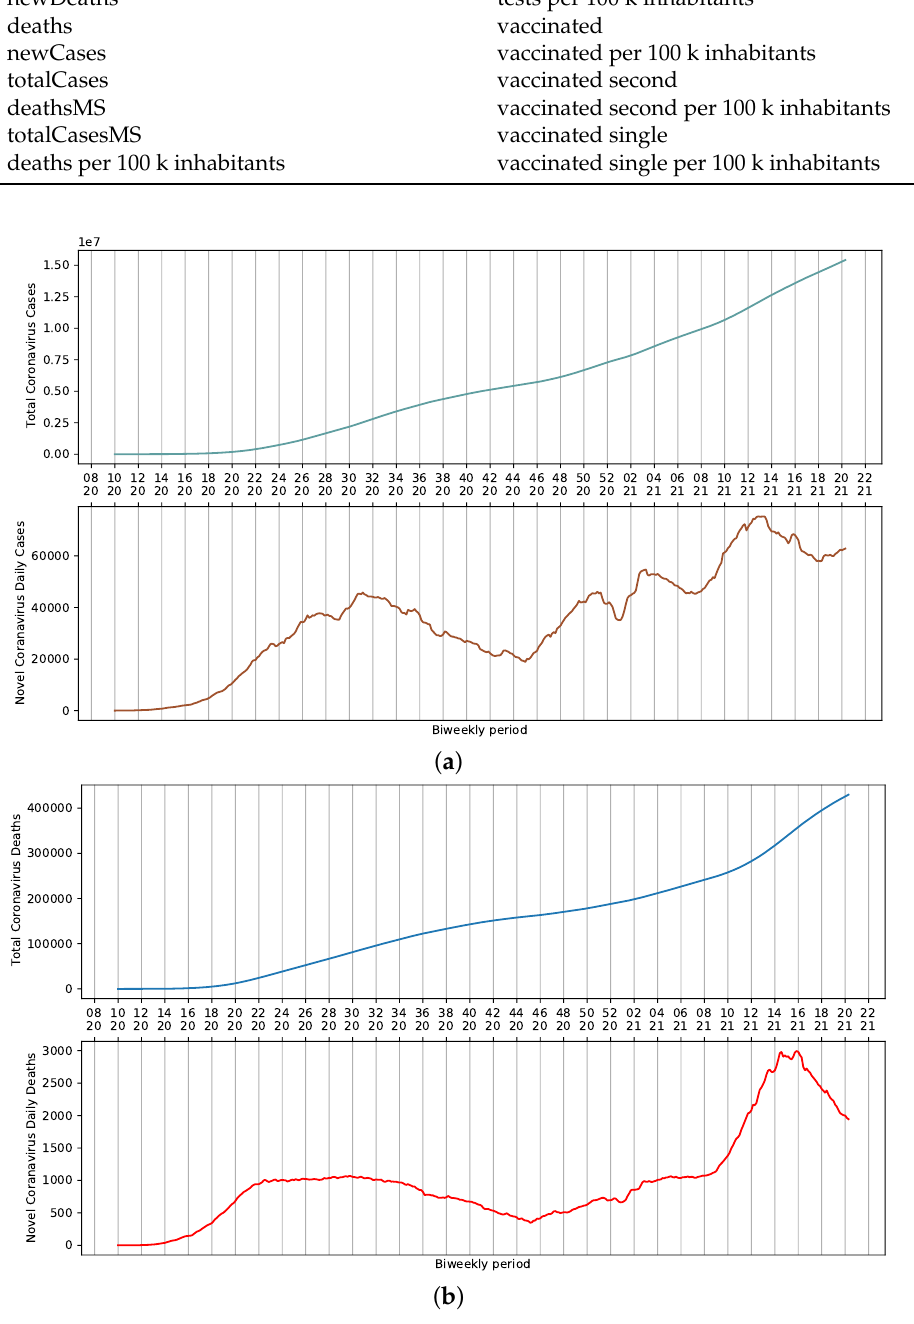
Figure 1. Moving average for COVID-19 in Brazil, presented according to epidemiological week. ( a ) Cumulative and daily case reports. ( b ) Cumulative and daily